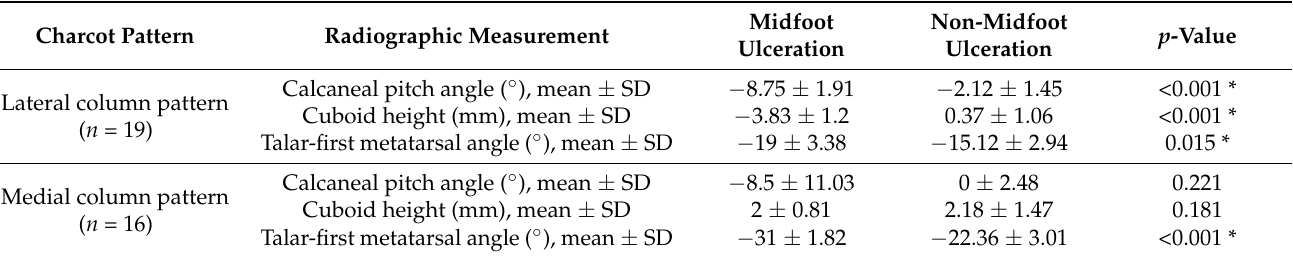
Table 2. Differences between radiographic measurements for CN patterns and the presence of midfoot